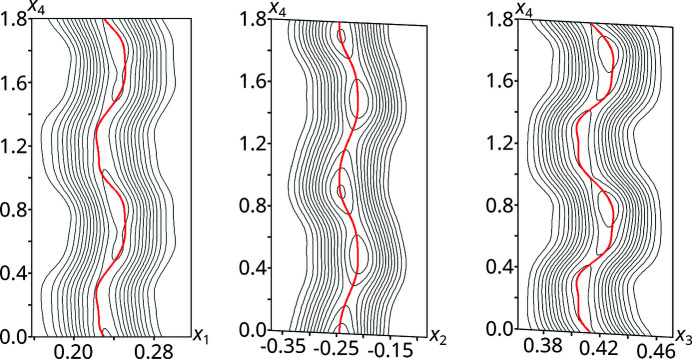
(x
1,x
4) (left), (x
2,x
4) (middle) and (x
3,x
4) (right) superspace sections centered at the position of O3 in the basic structure with 2 Å width. The refined positional displacement is indicated by red lines. Contours are drawn at constant 1 e Å−3 levels.